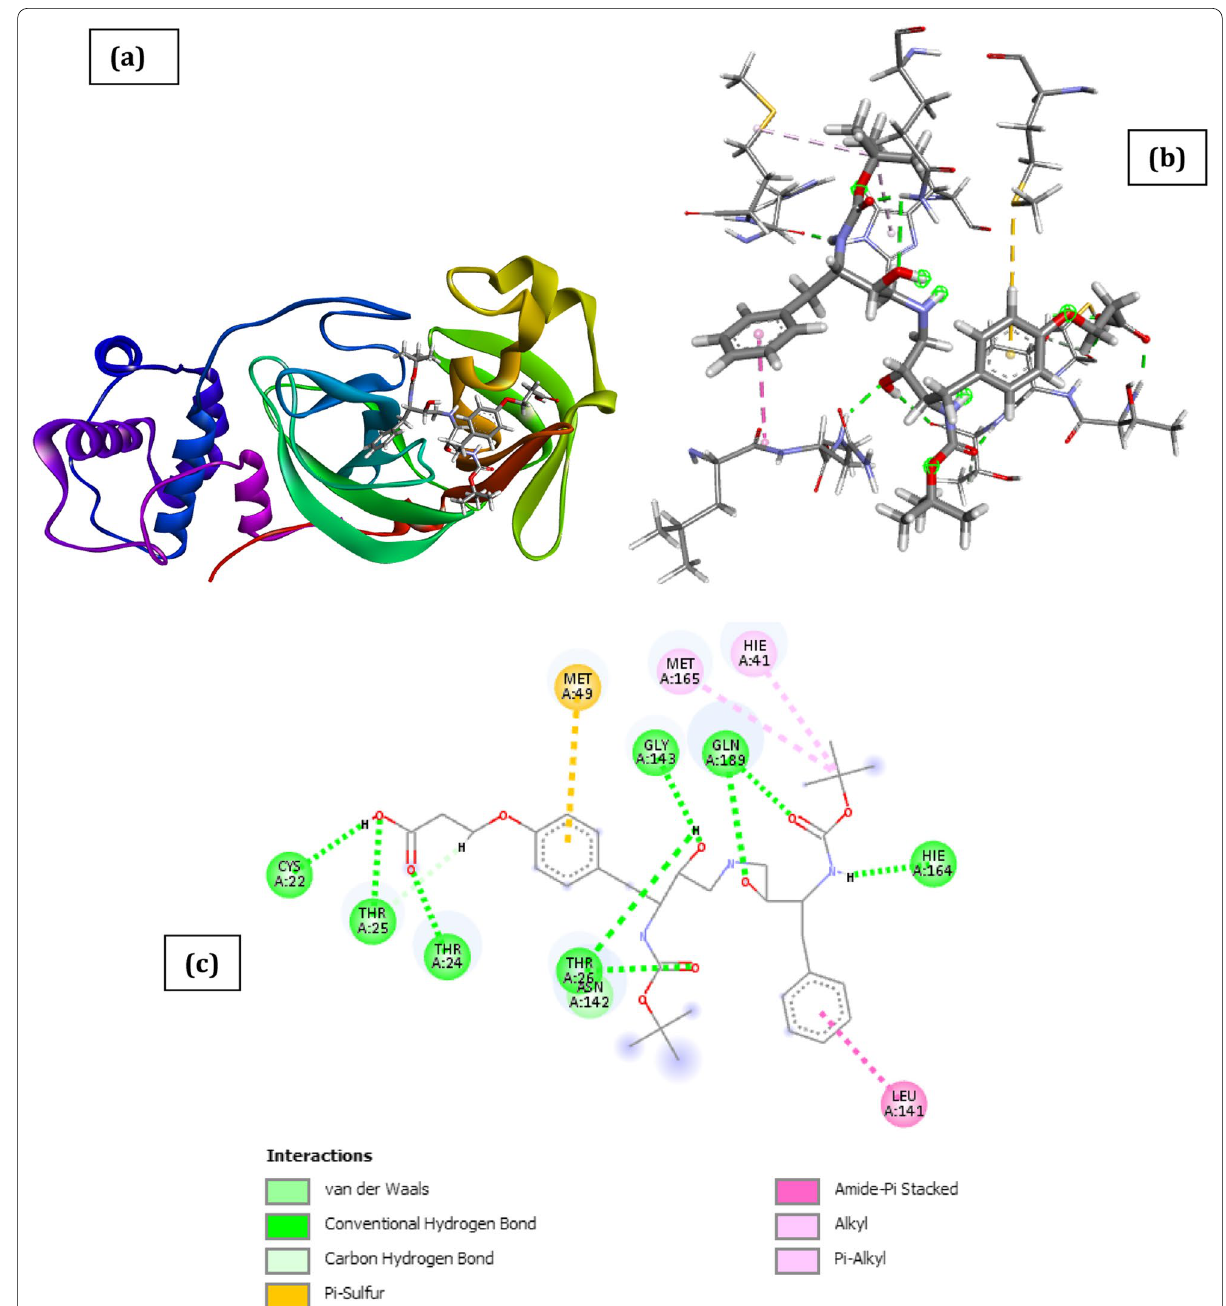
Fig. 3 Docked poses of SARS CoV 2 main protease (PDB ID: 6XBH) with inhibitor with Index number 441 (stick figure) a 3D view of docked pose of SARS CoV 2 Main Protease (PDB ID: 6XBH) with inhibitor with Index number 441; b 3D view of inhibitor with Index number 441 with surrounding amino acids of 6XBH; c 2D view of interaction type of inhibitor with Index number 441 with surrounding amino acids of